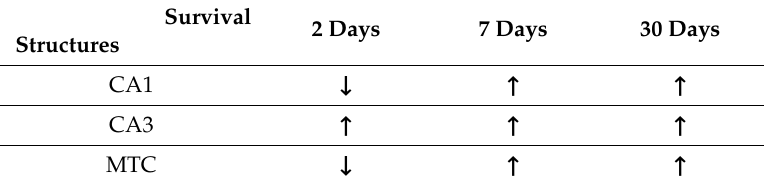
Table 1. Changes in the expression of the Alzheimer’s disease-associated amyloid protein precursor gene in di ff erent brain structures at di ff erent times after experimental brain ischemia. Survival 2 Days 7 Days 30 Days Structures CA1 ↓ ↑ ↑ CA3 ↑ ↑ ↑ MTC